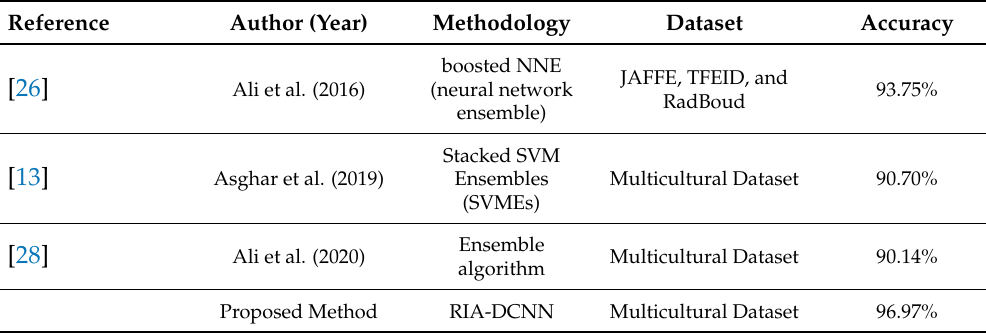
Table 6. Comparison with state-of-the-art